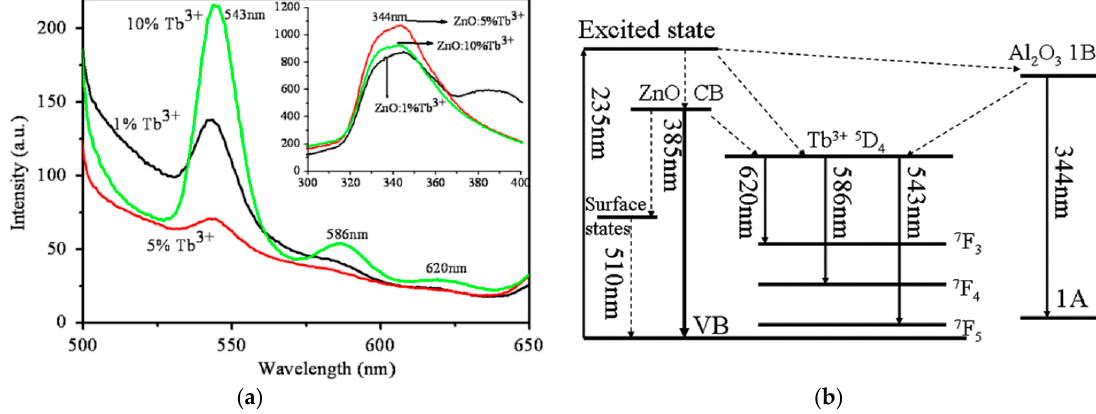
Figure 2. Photoluminescence properties of Tb-doped ZnO nanotubes. ( a ) Emission spectra of ZnO with different dopant levels excited by a 235 nm radiation; ( b ) energy-levels schematic with the electron transition processes in Tb-doped ZnO nanotubes grown onto alumina. Adapted from [114] .